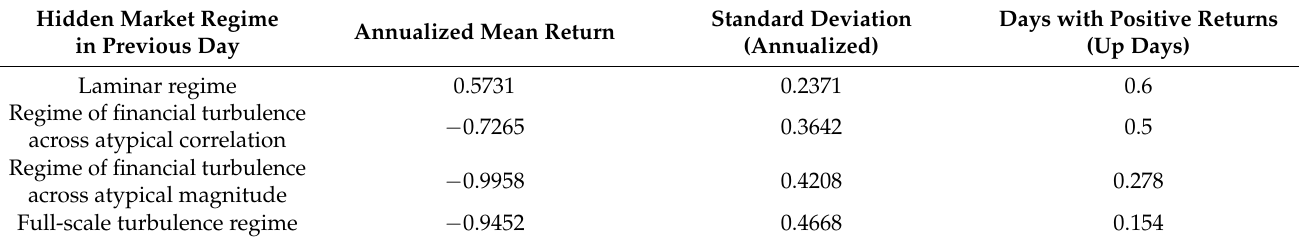
(0.5731), and the standard deviation was minimal (0.2361). Table 14. Daily returns distribution for the RTSI during switches among four Markov regimes.